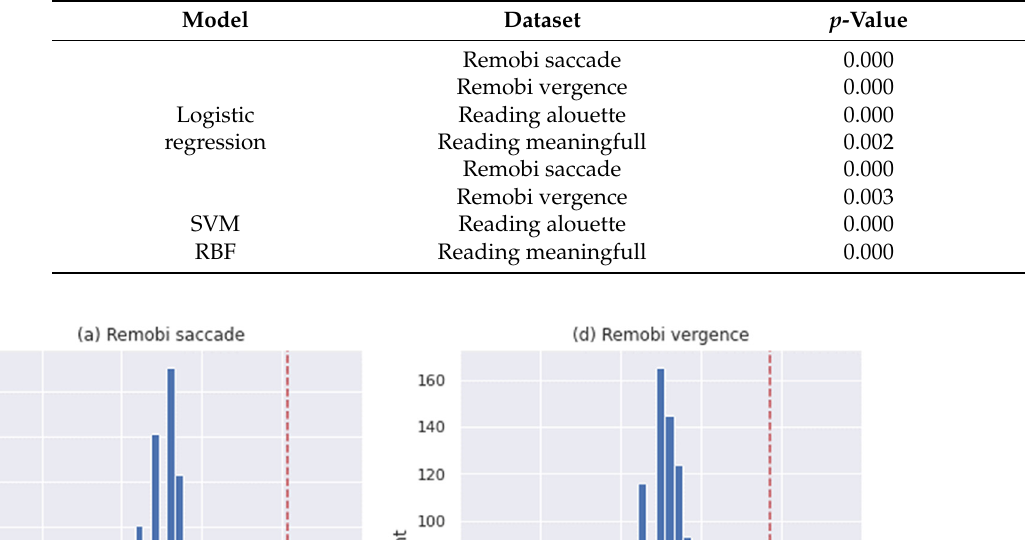
Table 4. Significance of reported results for Analysis 1.